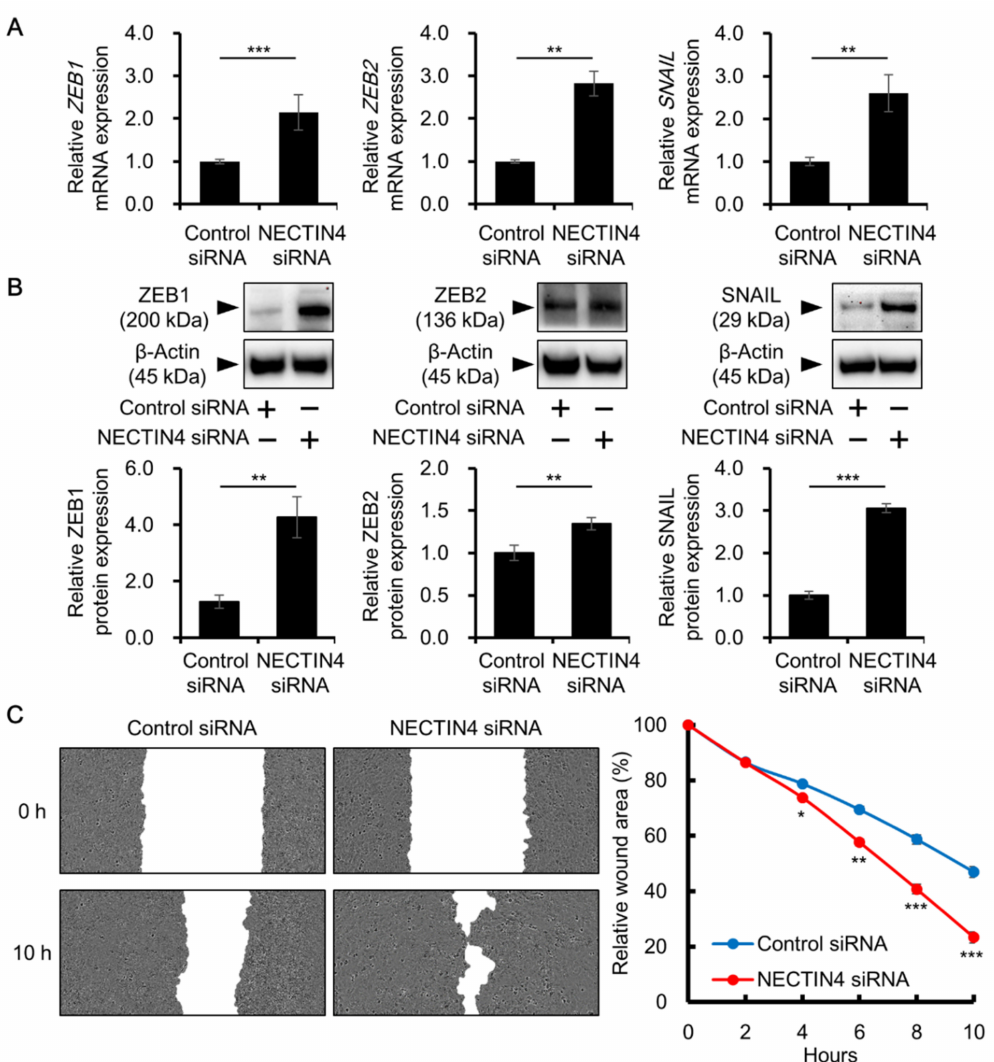
Figure 4. Effects of NECTIN4 inhibition on the migration of A431 cells. ( A , B ) Cells were transfected with control or NECTIN4 siRNA and the expression of ZEB1, ZEB2, and SNAIL was assessed at the mRNA level after 48 h ( A ) and at the protein level after 72 h ( B ). Data are the mean ± SD. ( n = 3). ** p < 0.01, *** p < 0.001. ( C ) Monolayers of control or NECTIN4 siRNA-transfected A431 cells were scratched, and cell migration was monitored up to 10 h at 2-h intervals. Representative images of the wound area at 0 and 10 h are shown for control and NECTIN4 siRNA-transfected A431 cells. The graph shows the mean ± SD of relative wound area. The migration assay was independently repeated three times and performed in 18 wells per condition. * p < 0.05, ** p < 0.01, *** p < 0.001 compared with control siRNA-transfected